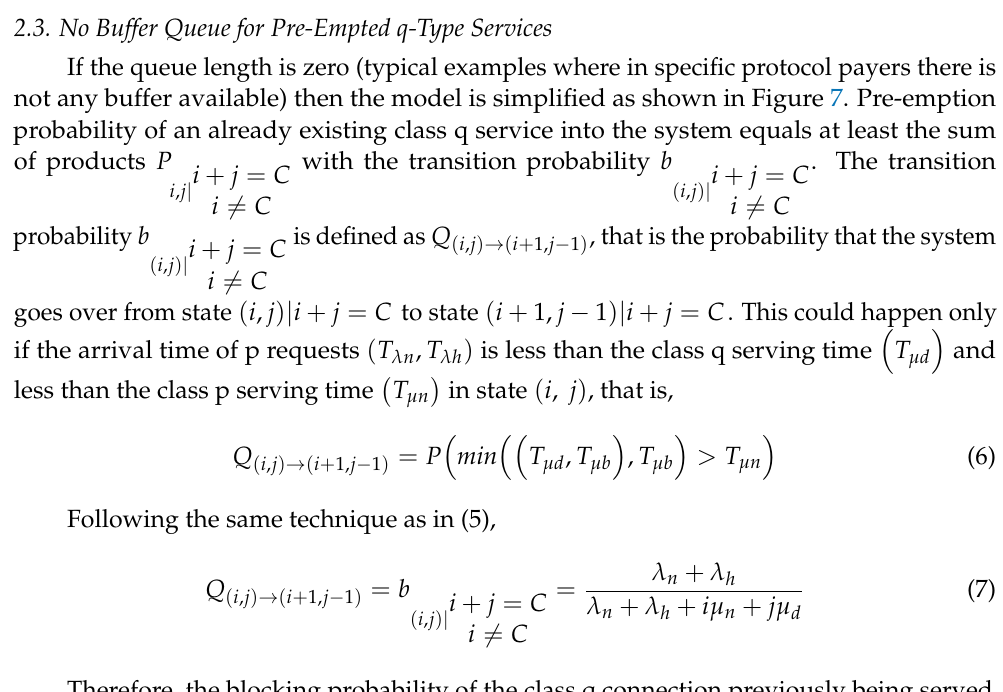
Figure 6. Third case of transition from states (2,2) or (2,1) into state (2,0).